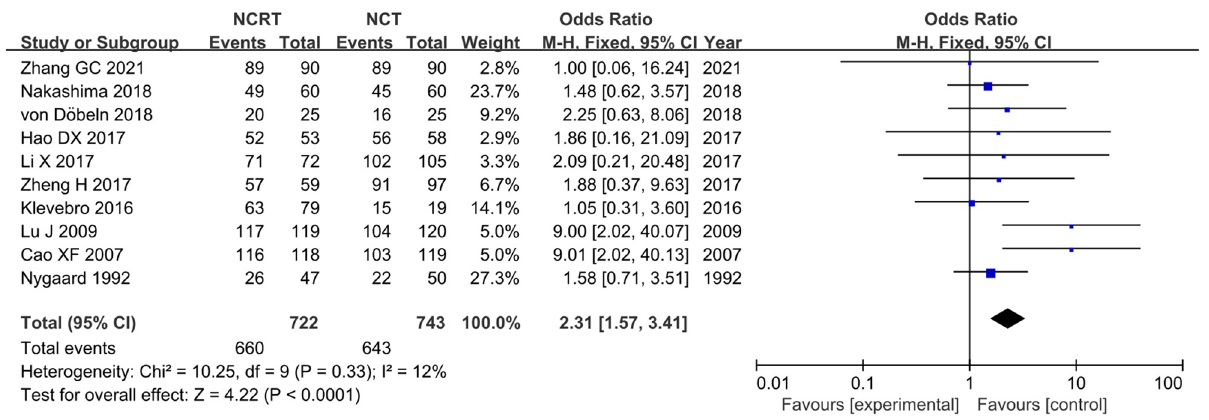
Fig 4. Forest plot for R0 resection of NCRT group and NCT